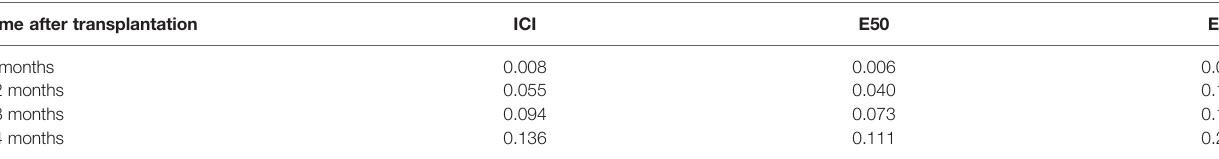
TABLE 3 | ICI, E50, and E90 in the internal validation of 320-patient primary cohort using bootstrapping method. Time after transplantation ICI E50 E90